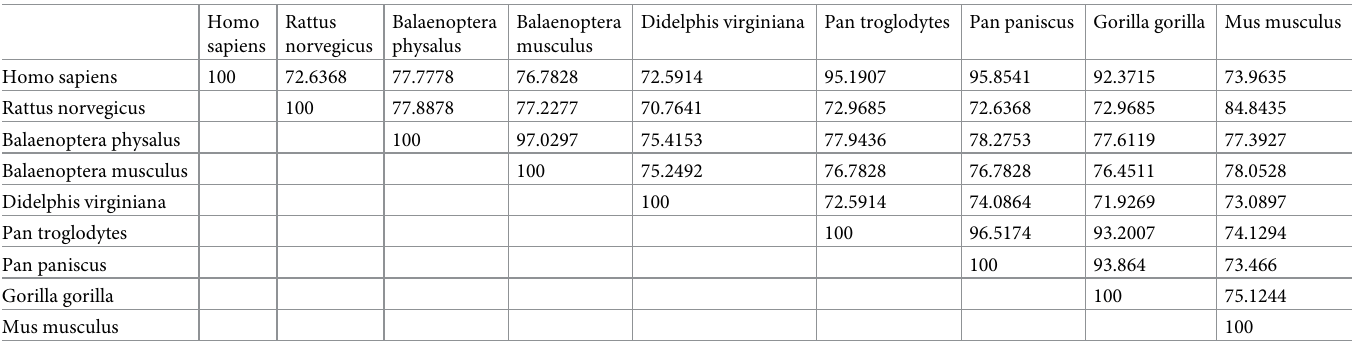
Table 2. The parameter Similarity of the HELIOS method in the quantitative measurement of homology. The Similarity measures the resemblance of two compared sequences (in percentage) aligned by the HELIOS method. Various amino acids are categorized into six groups based on their physicochemical properties; including GAVLI, FYW, STCM, KRH, DENQ, and P. Moreover, the “Nine ND5 protein sequences dataset” [53] is assumed in this study. Homo Rattus Balaenoptera sapiens norvegicus